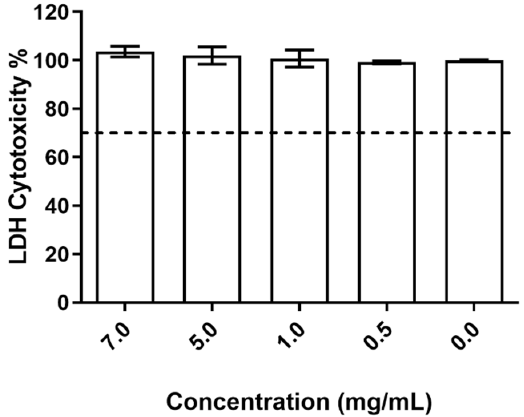
Figure 6. Evaluation of the produced NPs on HaCat cell wall integrity at the different concentrations tested. The dotted line represents the 30% cytotoxicity limit as defined by the ISO 10993‑5:2009 standard [32].